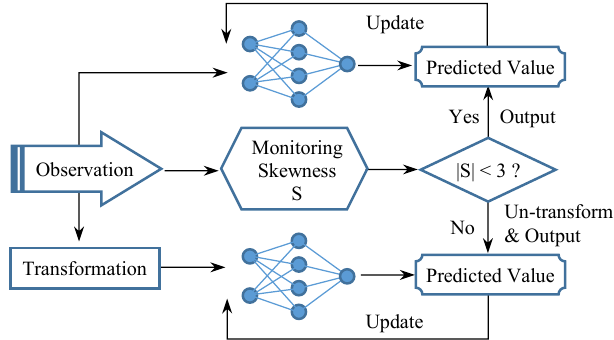
Figure 3. The redundancy mechanism for skewness-aware online edge